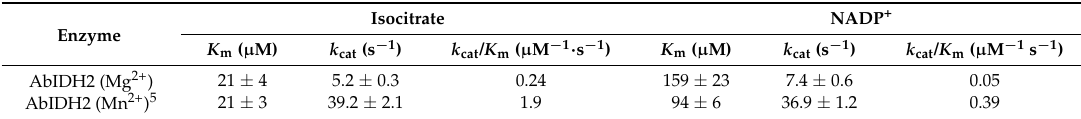
Table 1. The kinetic parameters of the recombinant